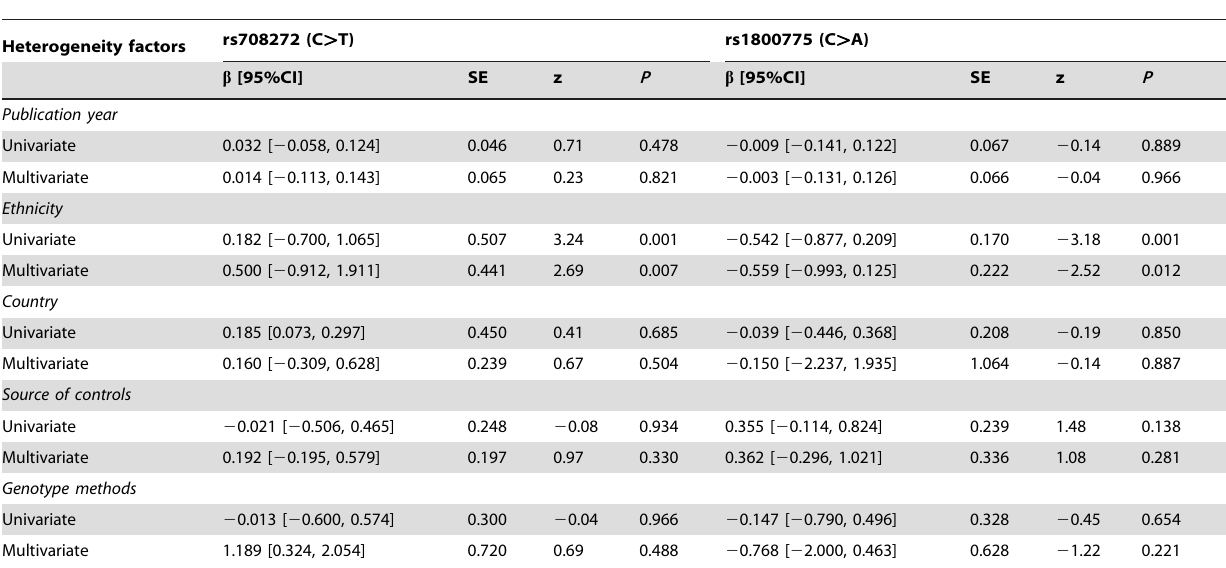
Table 4. Univariate and multivariate meta-regression analyses of potential source of heterogeneity.